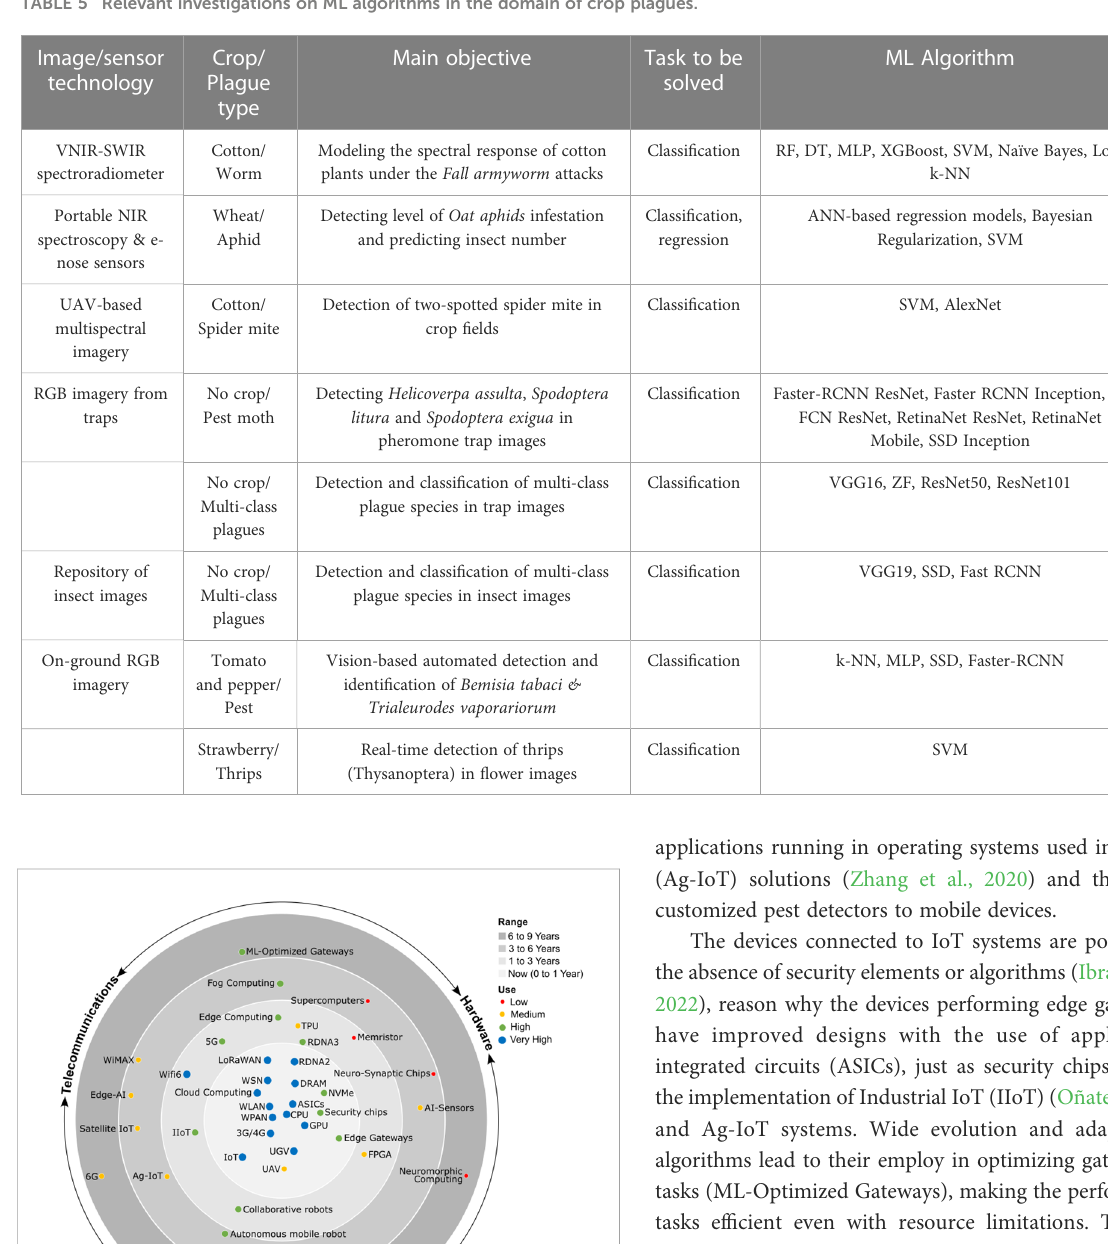
TABLE 5 Relevant investigations on ML algorithms in the domain of crop plagues.